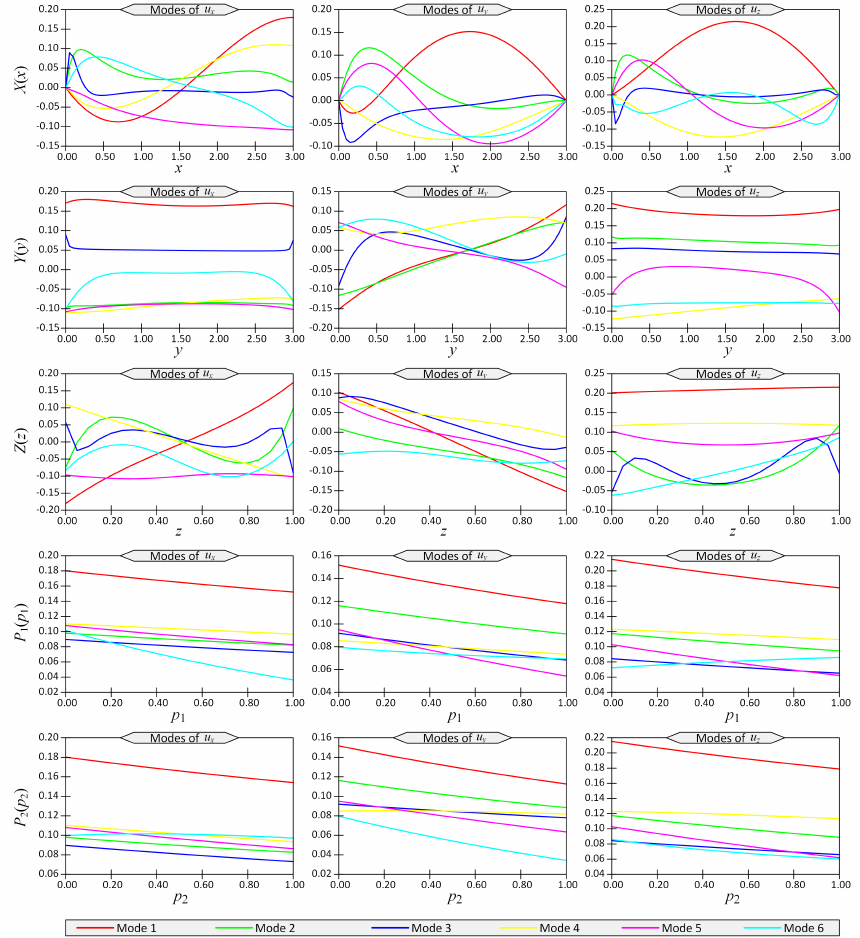
Figure 11. The first six modes of displacement components ( u x , u y , u z ) with respect to space coordi- nates ( x , y , z , p 1 , p 2 ) for Example